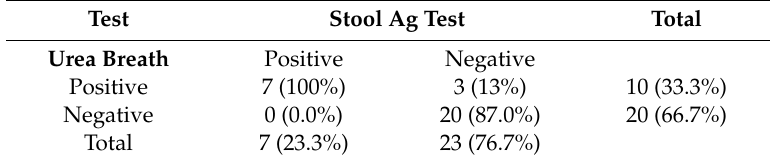
Table 4. Results of the 13 C-urea breath and stool antigen tests in the post-eradication group.